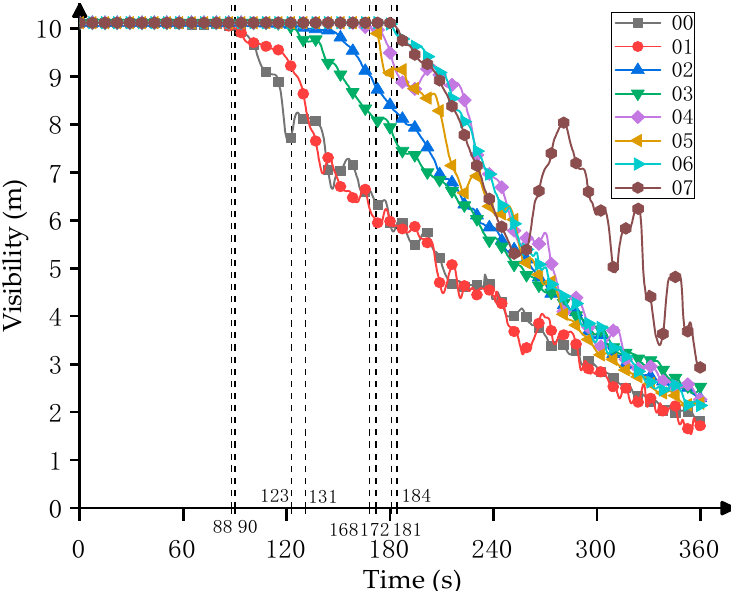
By sorting the data results of visibility in the fire at the end of the platform, the time when each monitoring point reached the critical value is obtained, as shown in Figure 9. It can be seen that the visibility of the 00–07 monitoring points decreases to below 10 m at 88 s, 90 s, 131 s, 123 s, 168 s, 172 s, 181 s and 182 s, respectively (namely, the critical value is reached).